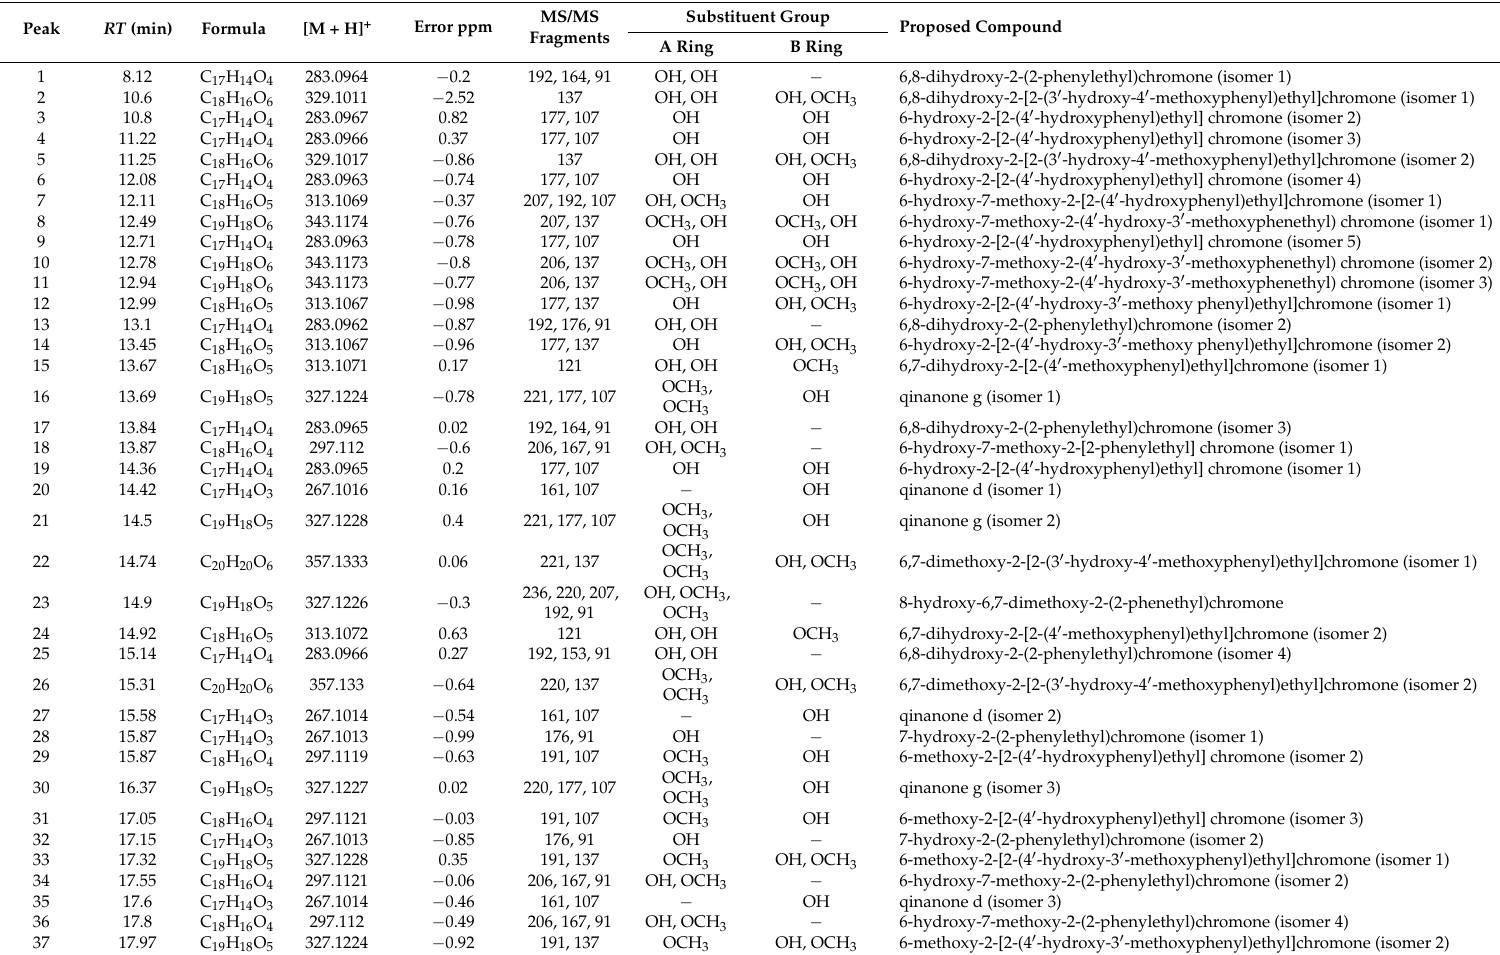
Table 1. Retention time (RT) and mass spectral data of the compounds characterized in agarwood extract by ultra-performance liquid chromatography coupled with electrospray ionization mass spectrometry (UPLC–ESI-QTOF-MS) and MS/MS in positive mode (2-(2-phenylethyl)-chromones (unoxidized) and 5,6,7,8-tetrahydro-2-(2-phenylethyl)-chromones). MS/MS Substituent Group Proposed Compound Peak Formula Fragments A